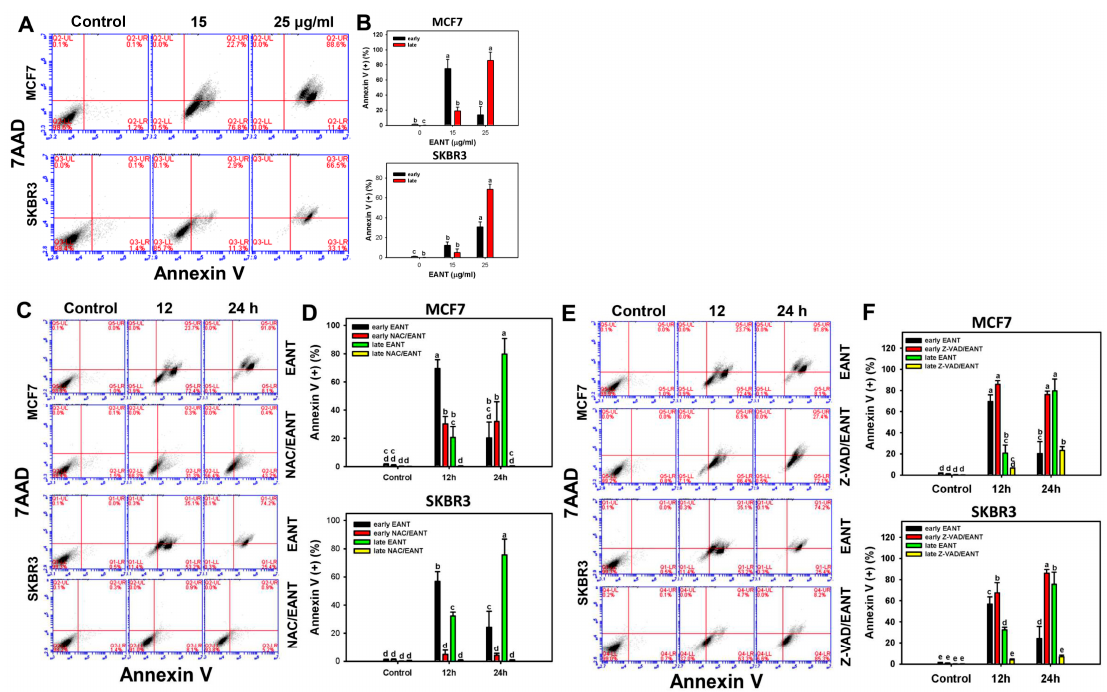
Figure 3. Apoptosis change of annexin V / 7AAD after EANT treatment. ( A , B ) Concentration e ff ect of EANT on Annexin V / 7AAD patterns and statistics. Breast cancer cells (MCF7 and SKBR3) were treated with control with DMSO only and EANT (15 and 25 µ g / mL) for 24 h. Annexin V ( + ) / 7AAD ( − ) and annexin V ( + ) / 7AAD ( + ) were respectively regarded as early and later apoptosis. ( C – F ) Time course e ff ect of EANT on Annexin V / 7AAD patterns and statistics. Without or with ( C , D ) NAC pretreatment or ( E , F ) Z-VAD pretreatment, breast cancer cells (MCF7 and SKBR3) were treated with 25 µ g / mL of EANT for 0 (control with DMSO only), 12, and 24 h. For each cell line, treatments labeled without the same lower-case letters indicate significant di ff erence. p < 0.01~0.0001. Data, mean ± SD ( n = 3). Positive controls for apoptosis are provided in Supplementary Figure